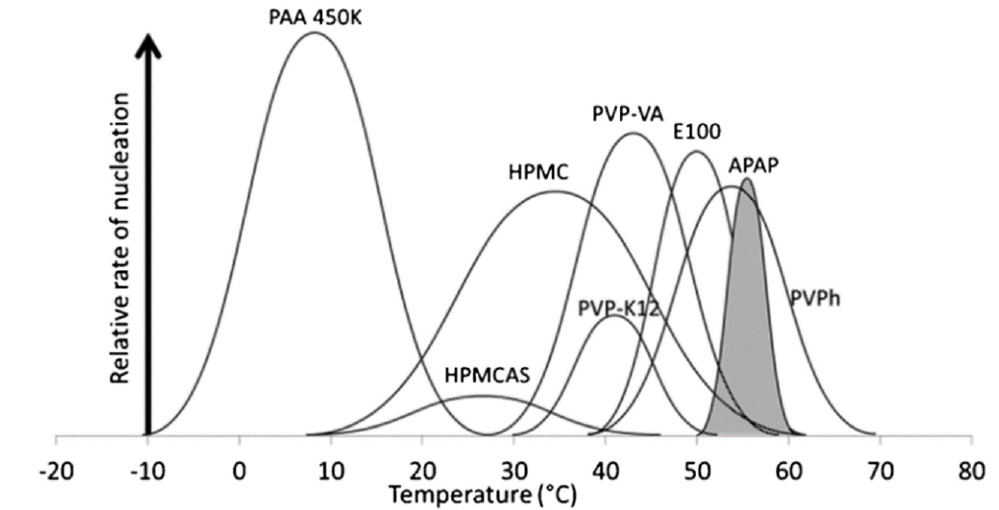
Figure 1. A semi-quantitative representation of the nucleation temperature zones and relative nucleation rates of pure acetaminophen (shaded region) and acetaminophen in the presence of 10% w / w polymers. Adapted from Ref. [25] with permission. Copyright © 2012 The Royal Society of